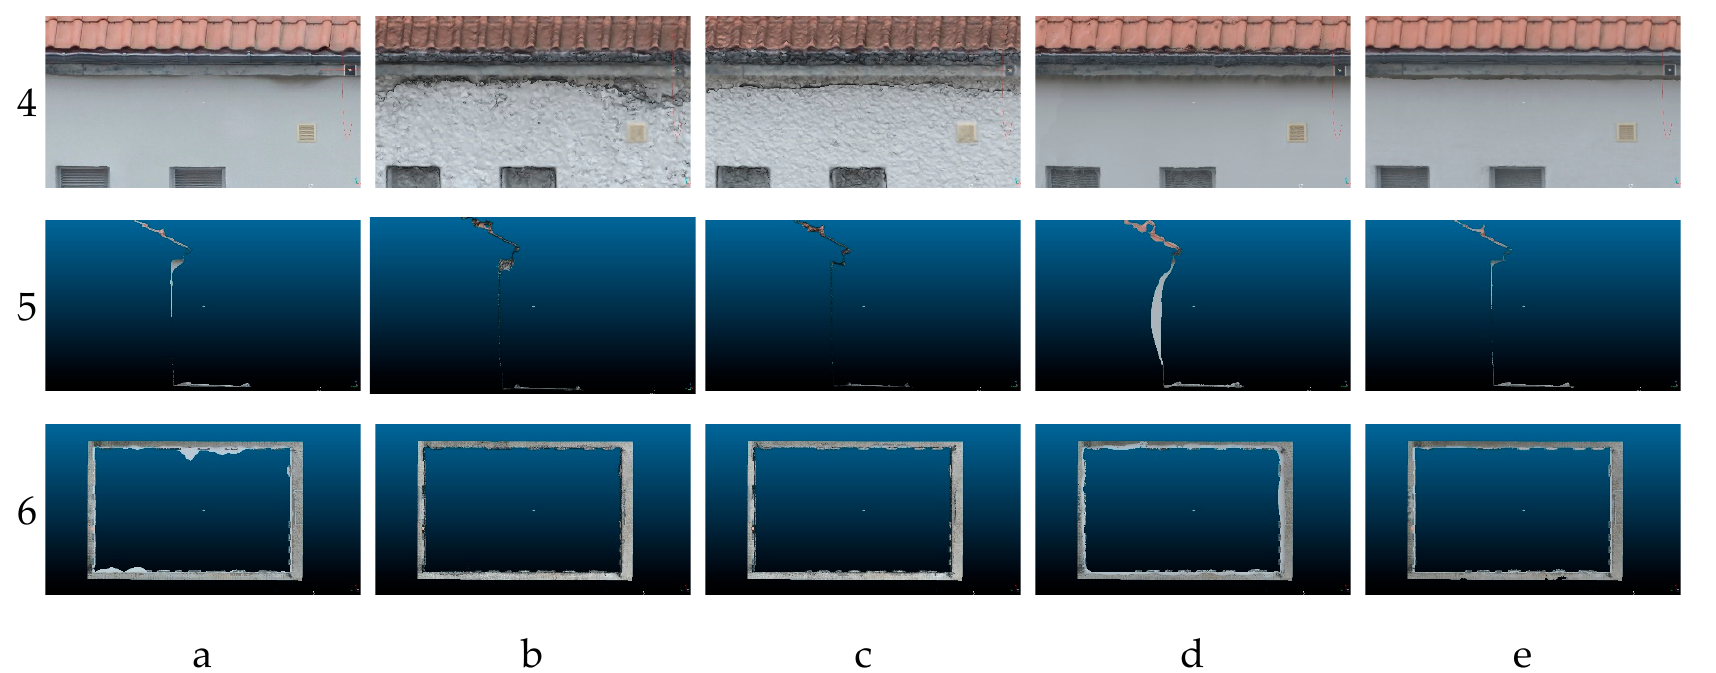
Figure A2. Comparison of the 3D mesh models generated in used software: ( a ) ContextCapture; ( b ) Metashape; ( c ) PhotoScan; ( d ) Pix4DMapper; ( e ) RealityCap- ture.